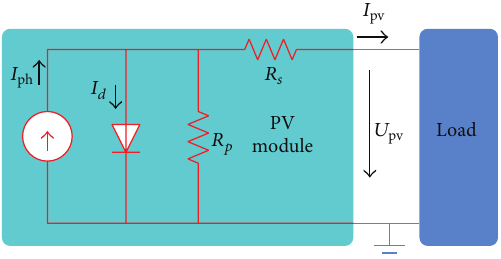
Figure 1: The equivalent electrical circuit of a photovoltaic